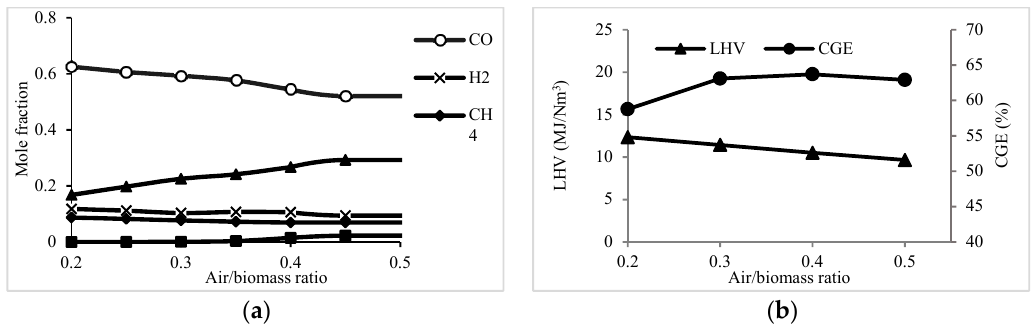
Figure 3. Effect of the equivalence ratio on ( a ) the gas composition and ( b ) the LHV and CGE. Figure 3. E ff ect of the equivalence ratio on ( a ) the gas composition and ( b ) the LHV and